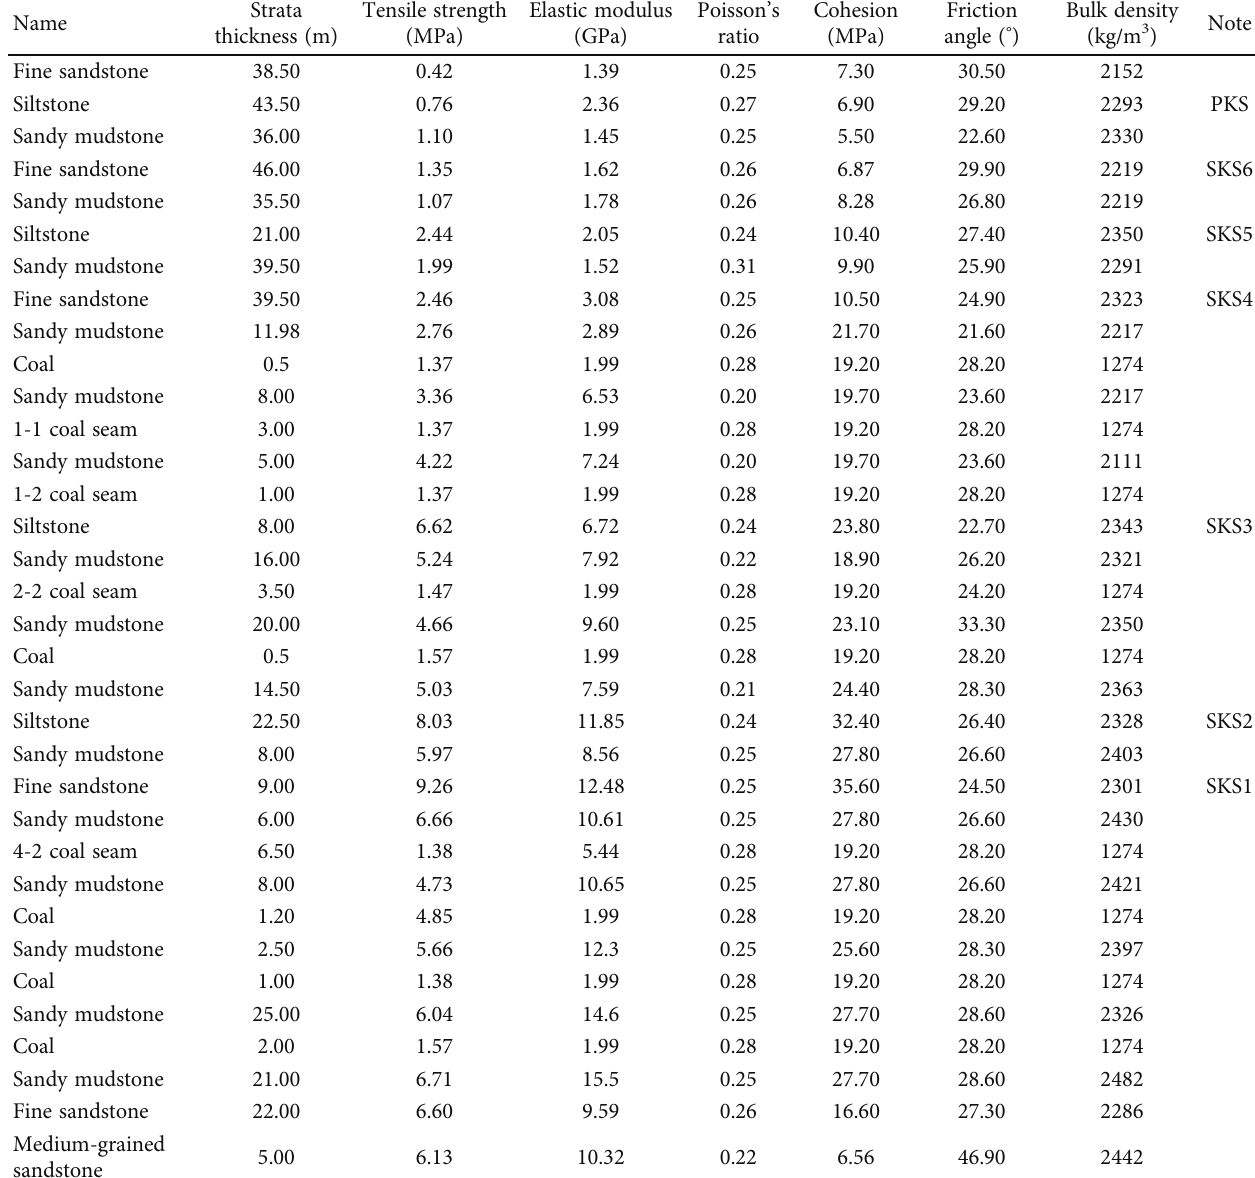
Table 1: Physical and mechanical parameters of the rocks and location of key